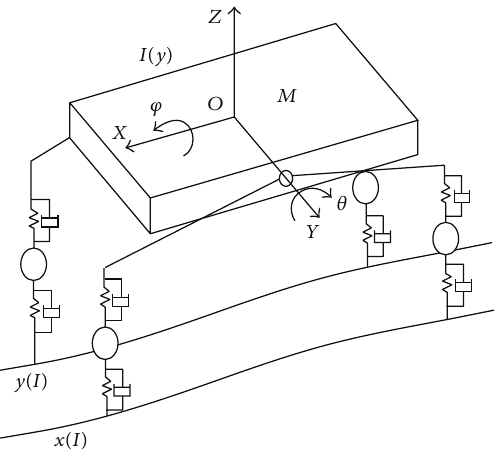
Figure 11: 3D dynamic simplification model of the wheel-tracked exploration